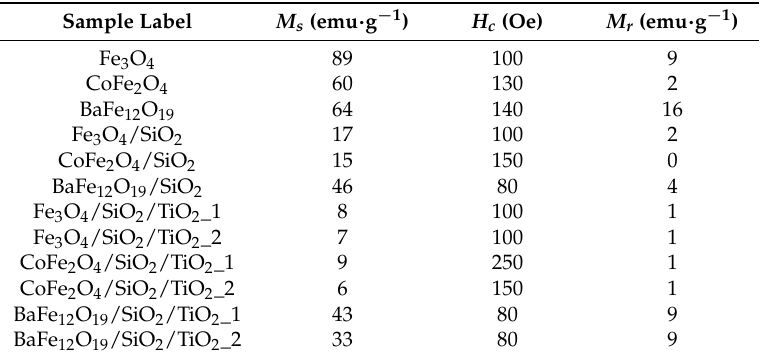
Table 2. Magnetic parameters of the uncoated and coated ferrite nanoparticles. Sample